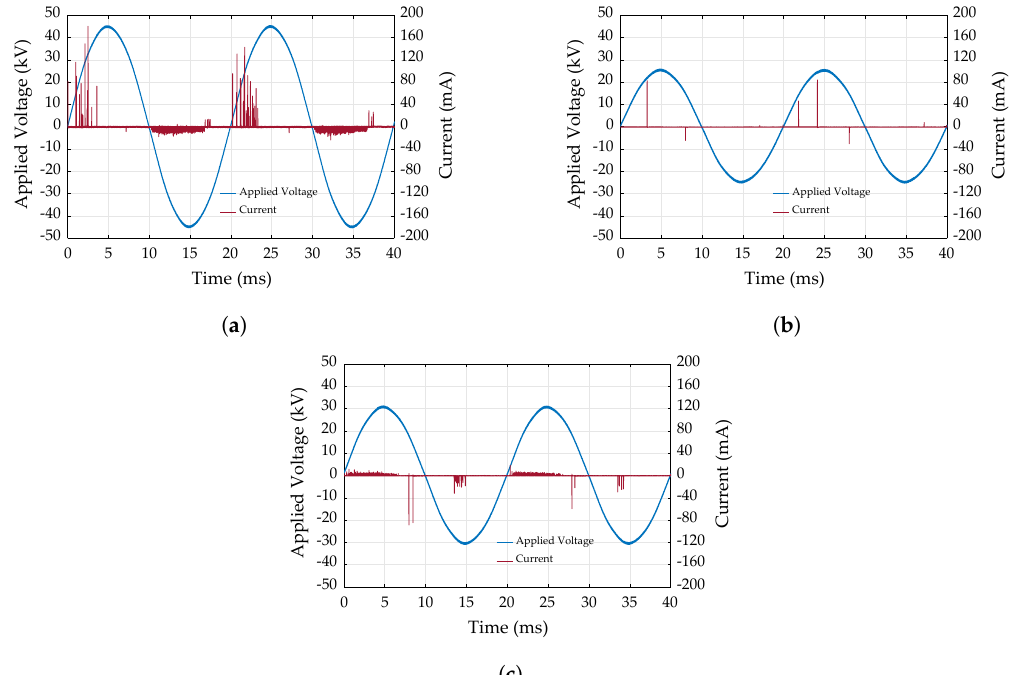
Figure 9. PTFE of 4mm thickness in ( a ) dry air at 1bar absolute pressure and 31.74kV rms applied voltage, ( b ) N 2 at 1bar absolute pressure and 17.74kV rms applied voltage and ( c ) CO 2 at 1bar absolute pressure and 21.61kV rms applied